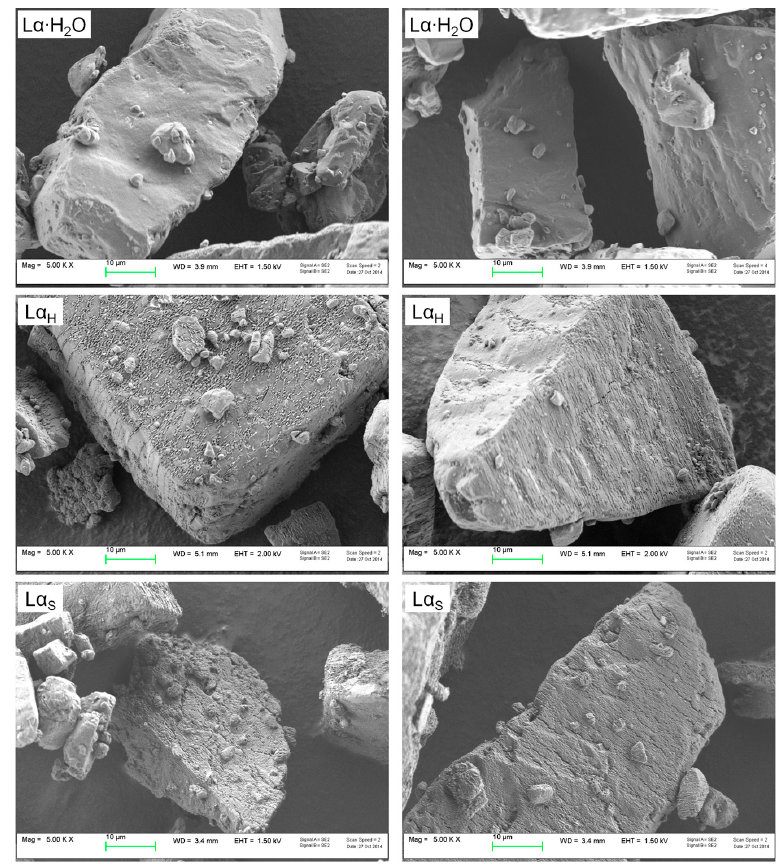
Figure 1. SEM micrographs of lactose carriers at 5000 × magnification: α -lactose monohydrate (as received), L α · H 2 O; hygroscopic anhydrous α -lactose, L α H ; stable anhydrous α -lactose, L α S .